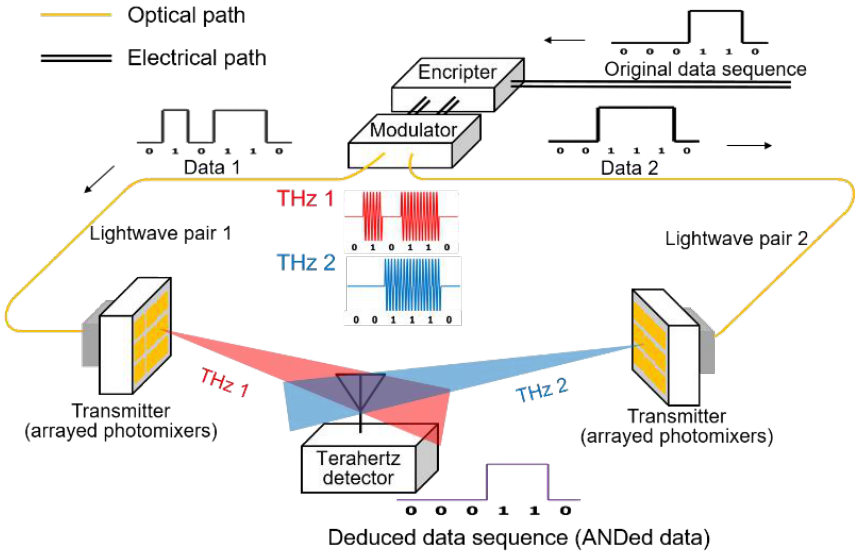
Figure 10. Secured wireless transmission system based on coherent detection between two RF data utilizing beam control.